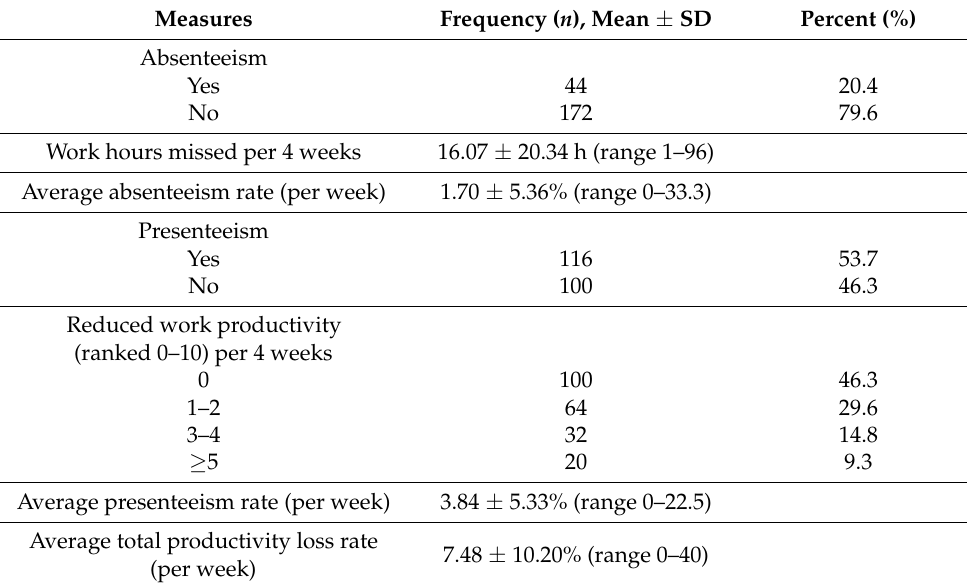
Table 4. Work productivity loss measures in study